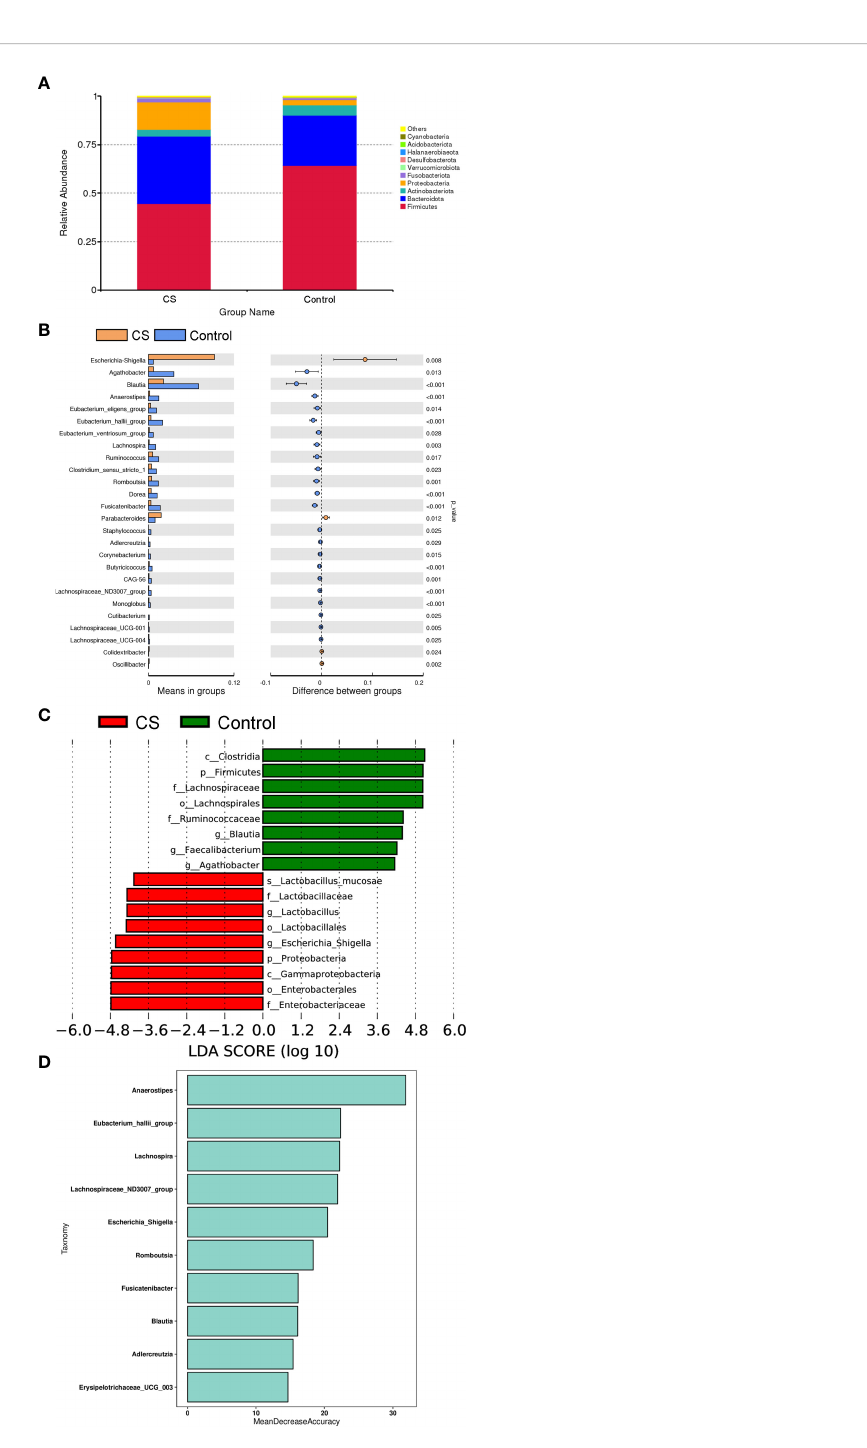
FIGURE 2 Difference in speci fi c taxa between Cushing ’ s syndrome patients and controls. (A) : The relative abundance of gut microbiota at the phylum level showing that Firmicutes were signi fi cantly decreased in the CS group ( P <0.001), while taxa in the Proteobacteria were increased ( P <0.01). (B) : The relative abundance of gut microbiota at the genus level showing that the relative abundance of Agathobacter , Blautia , Anaerostipes , Eubacterium_eligens_group , and Lachnospira were decreased in the CS group (p <0.05), while the proportions of Escherichia-Shigella and Parabacteroides were enriched (p <0.05). (C) : LEfSe analysis demonstrated that Escherichia-shigella from Proteobacteria was a dominant genus in the gut microbiota of CS patients. (D) : Random forest analysis displayed the importance of speci fi c taxa in groups. CS,Cushing ’ s syndrome; LDA,Linear Discriminant